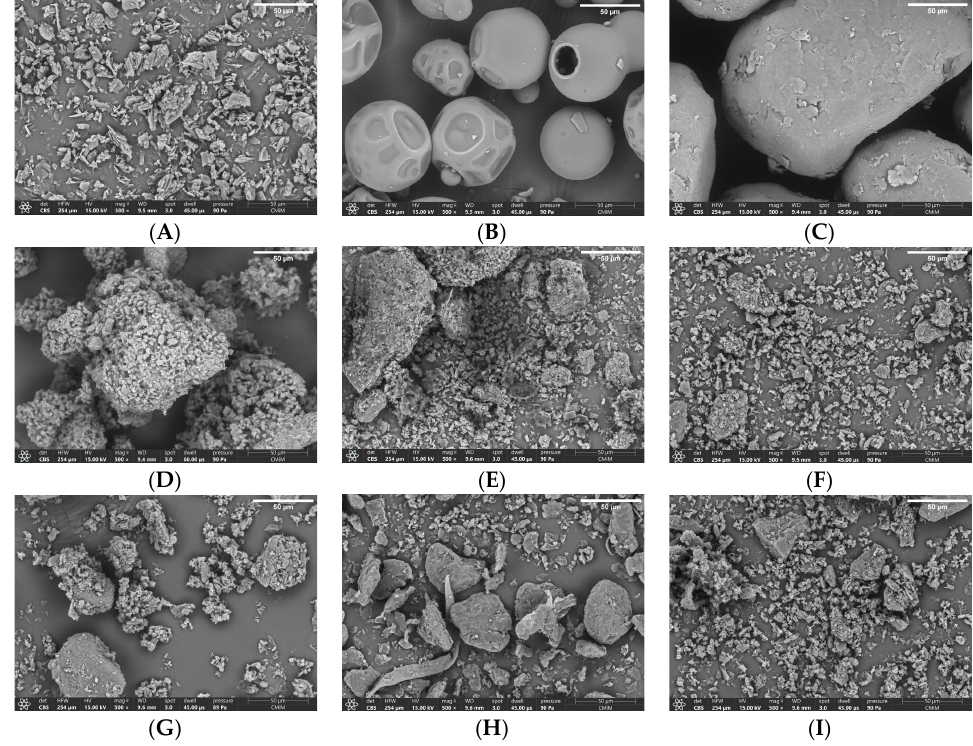
Figure 7. SEM Observations for ( A ) Ketoprofen, ( B ) PVP, ( C ) PVA, ( D ) CG-1, ( E ) CG-2, ( F ) CG-3, ( G ) CG-4, ( H ) CG-5, and ( I ) CG-6 at magnification of 500× (scale bar shown in the figure: 50 µm).